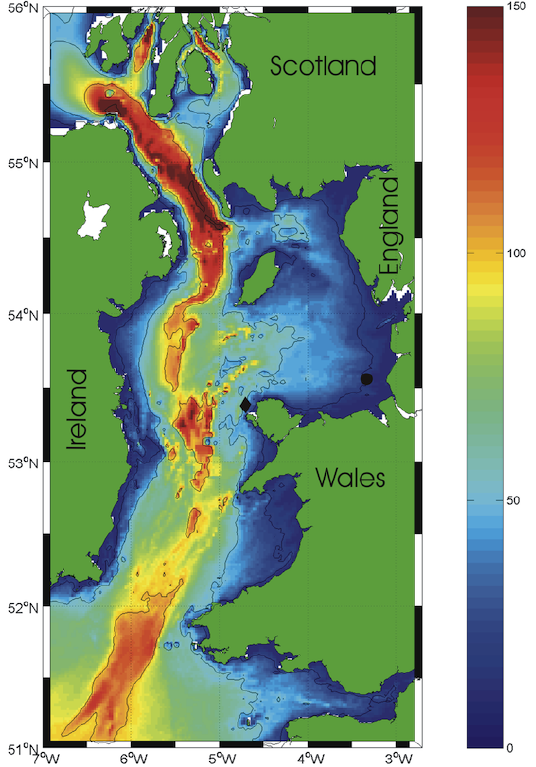
Fig. 5. Ellipticity values in the Irish Sea: positive values are cyclonic negative values are